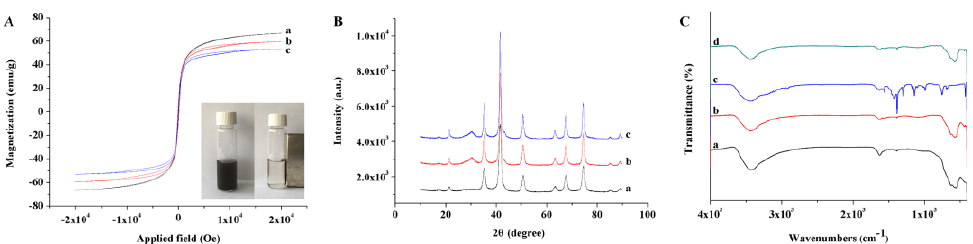
Figure 3. ( A ) magnetic hysteresis loops for ( a ) Fe 3 O 4 ; ( b ) magnetic multiwalled carbon nanotubes; and c ) zeolitic imidazolate framework based on magnetic multiwalled carbon nanotubes. The insert shows magnetic separation and dispersion of zeolitic imidazolate framework based on magnetic multiwalled carbon nanotubes; ( B ) X-ray diffraction patterns of ( a ) Fe 3 O 4 ; ( b ) magnetic multiwalled carbon nanotubes; and c ) zeolitic imidazolate framework based on magnetic multiwalled carbon nanotubes; ( C ) Fourier-transform infrared spectra of ( a ) Fe 3 O 4 ; ( b ) magnetic multiwalled carbon nanotubes; ( c ) zeolitic imidazolate framework-67; and ( d ) zeolitic imidazolate framework based on magnetic multiwalled carbon nanotubes.